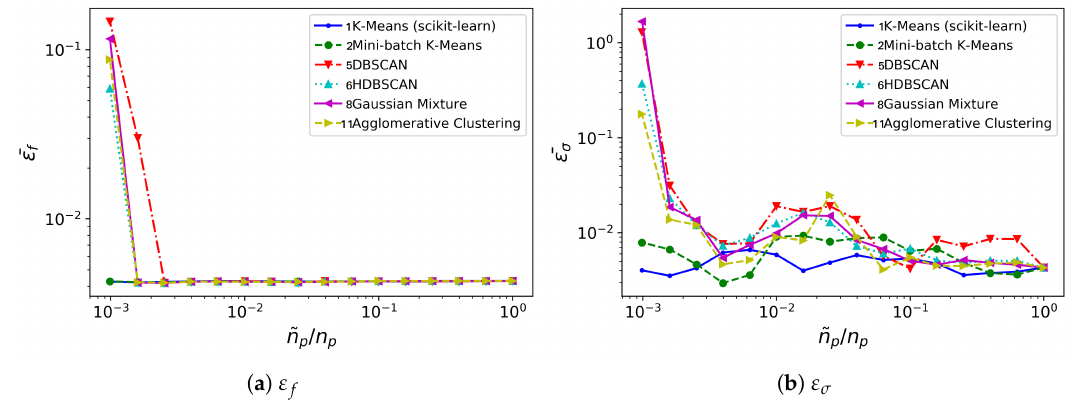
Figure 9. Re D = 60 cylinder flow: Normalized errors ε f (Equation (14)) and ε σ (Equation (15)) committed on capturing the top 4 frequencies f i and corresponding growth rate σ i with different clustering algorithms over spatial reduction (cid:102) n p / n p < 1.